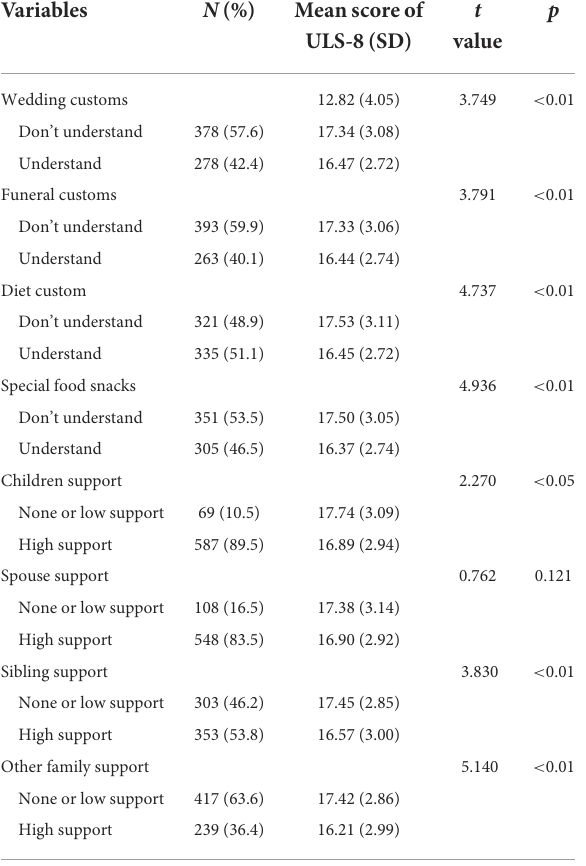
there are two figures in Figure 1: the upper figure shows the relationship between acculturation and loneliness, while the lower figure illustrates the mediating effect of family support on the association between acculturation and loneliness. In addition, the SEM could be used not only to analyze empirical relationships between different variables in the model but also to analyze statistical associations between observed and unobserved variables simultaneously. In this study, there were three unobserved variables: acculturation, family support, and loneliness. Among them, acculturation and family support were both represented by four observation variables, and loneliness was represented by eight observation variables. As illustrated in Figure 1 (upper figure), acculturation exerted a negative effect on loneliness (the standardized effect = − 0.25, p < 0.01). Moreover, as shown in Figure 1 (lower figure), acculturation exerted a negative effect on loneliness (the standardized effect = − 0.22, p < 0.01), family support also exerted a negative effect on loneliness (the standardized effect = − 0.31, p < 0.01), and acculturation exerted a positive effect on family support (the standardized effect = 0.12, p < 0.05).